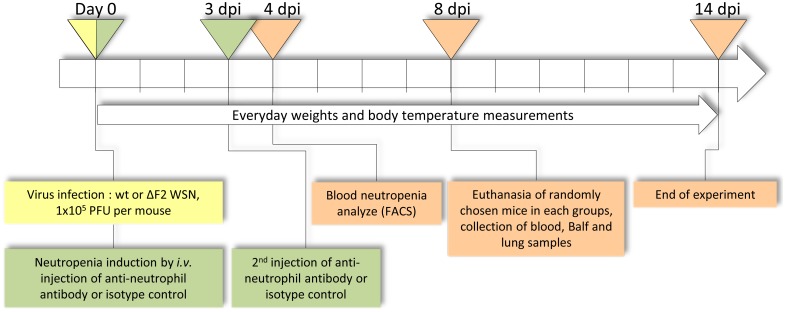
Graphical representation of the neutropenia induction timeline.Ten mice per group were used.